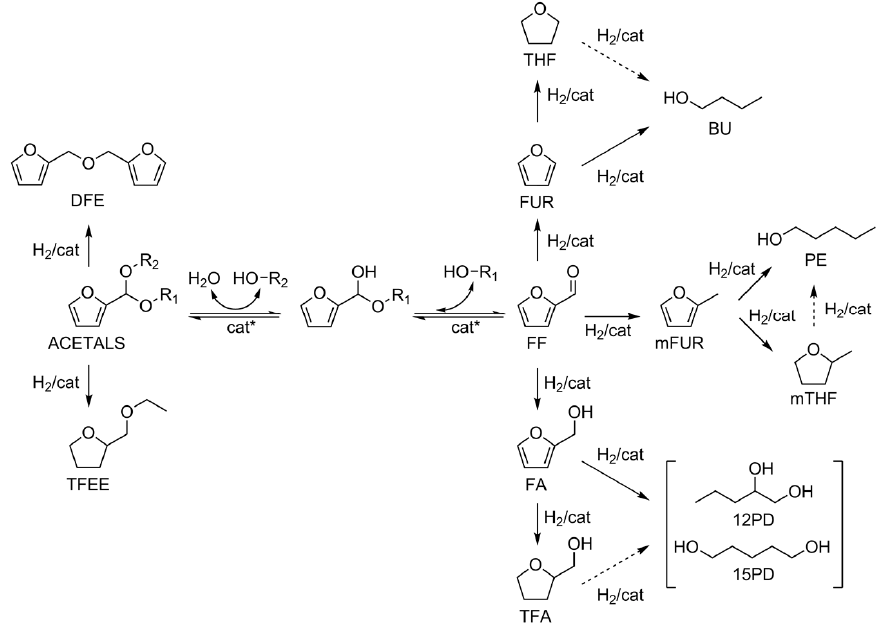
Figure 8. Furfural conversion and product selectivity over Ni 2 Mg 1 Al-R: effect of hydrogen pressure at 4 h and 190 °C using 5 wt.% FF in ethanol (the dashed lines only indicate trends). Increasing the hydrogen pressure in Ni 2 Mg 1 Al-R promoted the formation of FA and but decreased at higher pressure, and it was not detected significantly at 50 bar. Pressure